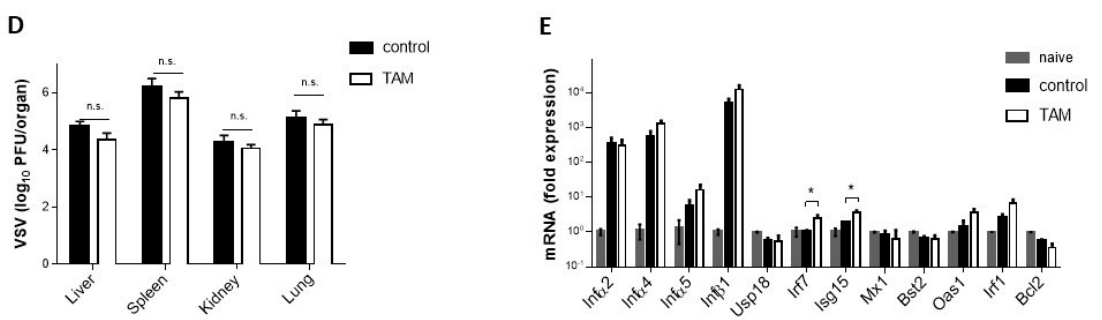
Figure 4. Inhibitory e ff ect of TAM on early VSV replication requires interferon. ( A ) The mRNA expression of type I interferon from spleen tissue was determined by quantitative real-time PCR (qRT-PCR) 8 h after infection with 2 × 10 8 PFU VSV in TAM pretreated and control mice ( n = 5). ( B ) Interferon α concentrations were examined in sera of TAM-pretreated and control mice at 24 and 48 h after infection with 2 × 10 8 PFU VSV ( n = 6). ( C ) The mRNA expression of indicated interferon-induced genes from spleen tissue was determined by quantitative real-time PCR (qRT-PCR) 8 h after infection with 2 × 10 8 PFU VSV in TAM-pretreated and control mice ( n = 5). ( D ) Ifnar − / − mice were pretreated intraperitoneally with 4 mg TAM or corn oil used as control at day -3 and -1, followed by VSV infection with 2 × 10 6 PFU. Virus titers were determined in the liver, spleen, kidney, and lung of Ifnar deficient mice tissues 8 h post infection ( n = 6). ( E ) The mRNA expression of indicated interferon-induced genes from spleen tissue was determined by quantitative real-time PCR (qRT-PCR) in Ifnar − / − mice after treatment with 4 mg TAM at day -3 and -1 or corn oil used as control ( n = 4). Spleen tissues were harvested 8 h post infection with 2 × 10 8 PFU of VSV. Data are expressed as means ± SEM. n.s.: not significant, * p = 0.05; ** p = 0.01; *** p = 0.001; **** p < 0.001.